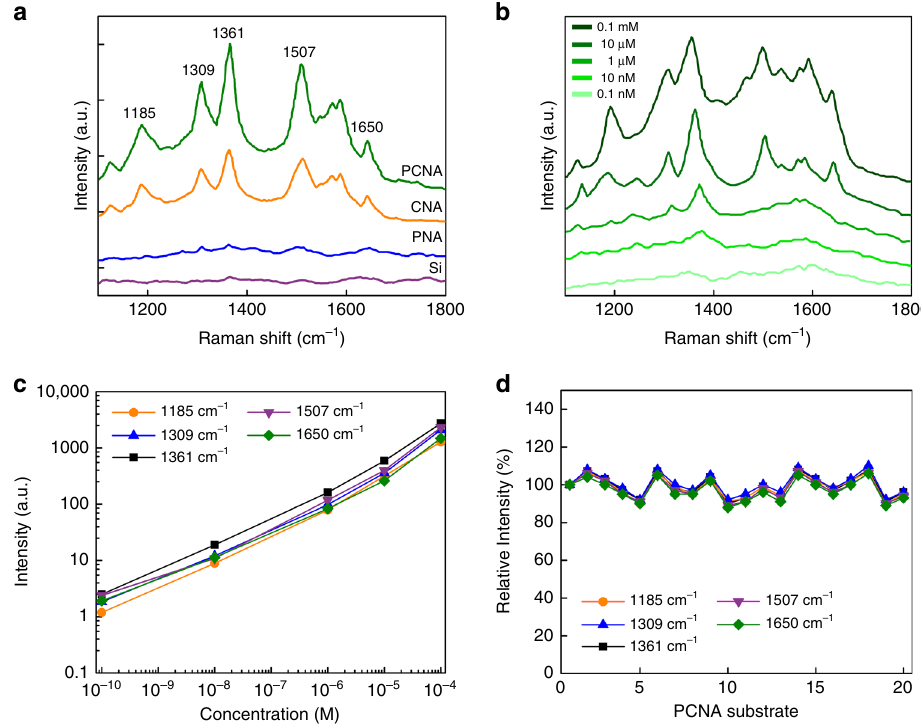
Fig. 2 SERS of R6G on the PCNA substrate. a Measured Raman spectra of R6G molecules at a concentration of 10 μ M on the silicon (red), PNA (blue), CNA (orange), and PCNA (green) substrates for an integration time of 30 s with an excitation power of 1 mW at 785 nm after cleaning the substrates. b Measured Raman spectra of R6G molecules at different concentrations adsorbed on the PCNA substrate for an integration time of 30 s with an excitation power of 1 mW at 785 nm. c Intensities of the Raman peaks at different concentrations at 1185, 1309, 1361, 1507, and 1650 cm − 1 . The detection limit of the PCNA substrate for R6G molecules is about 10 nM. d SERS reproducibility measurements of R6G molecules on different PCNA substrates. The differences in the relative intensities of the Raman peaks at 1185, 1309, 1361, 1507, and 1650 cm − 1 between 20 different substrates are within a standard deviation of